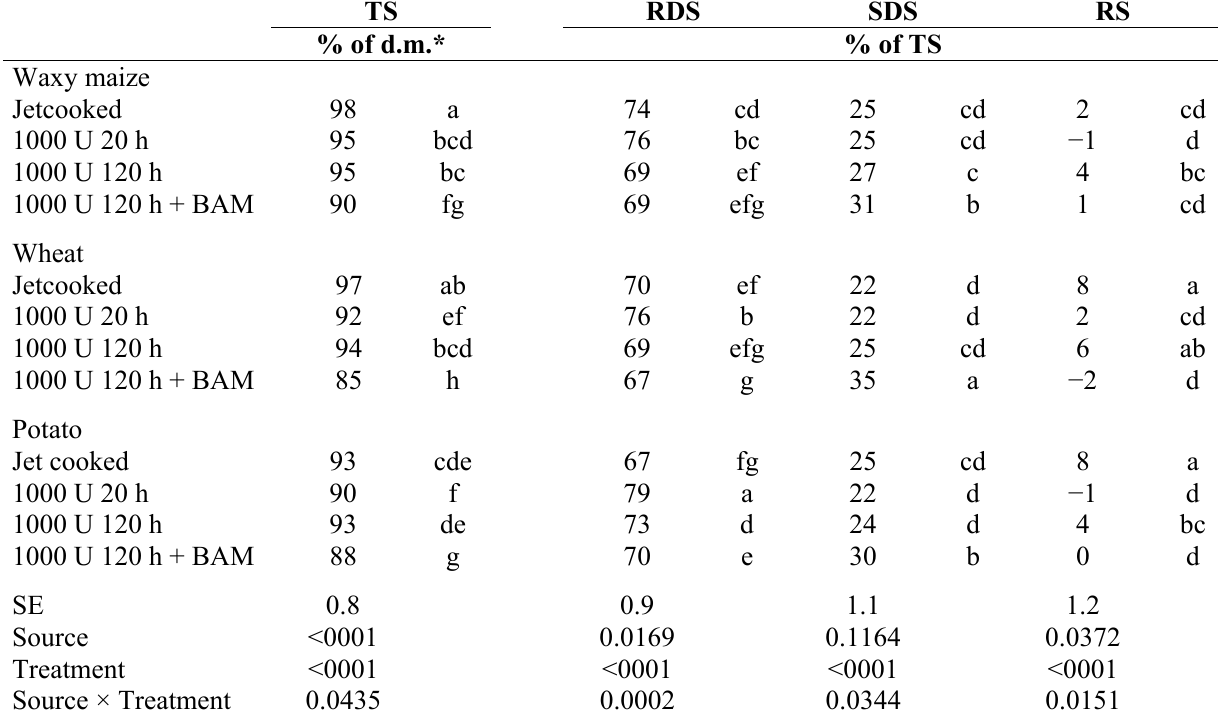
Table 3. Effect of branching enzyme at different incubation of time and addition of β -amylase on different starch